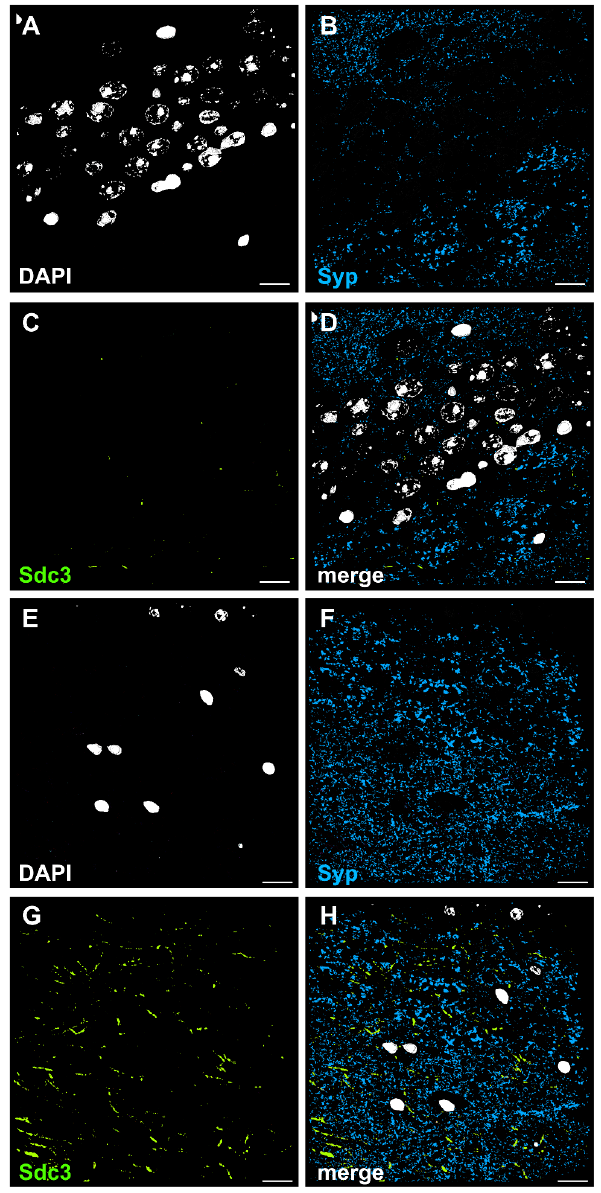
Figure 6. Array tomography images demonstrating localization of Syndecan3-immunoreactive spots in mouse hippocampus. ( A – D ) Images taken in CA1 stratum pyramidale, 3D render of 20 consecutive 70 nm sections. A: DAPI, B: Synaptophysin (Syp), C: Syndecan3 (Sdc3), D: merged. ( E – H ) Images taken in CA1 stratum radiatum, 3D render of 16 consecutive 70 nm sections E: DAPI, H: Synaptophysin, G: Syndecan3, H: merged. Scale bars: 50 μ m.